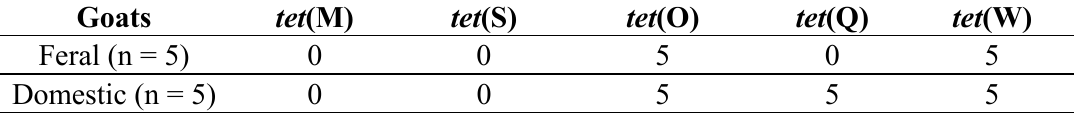
Table 2. Detection of Tetracycline resistance genes in feces from feral and domestic goats.